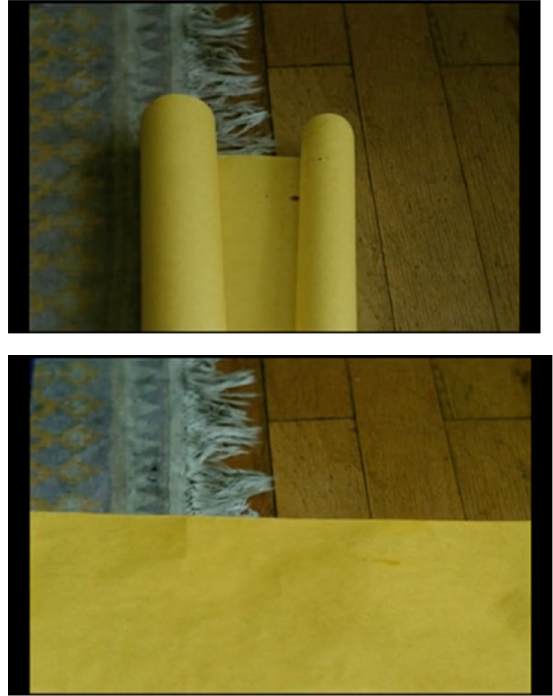
Figure 5. The Room Called Heaven (2012).